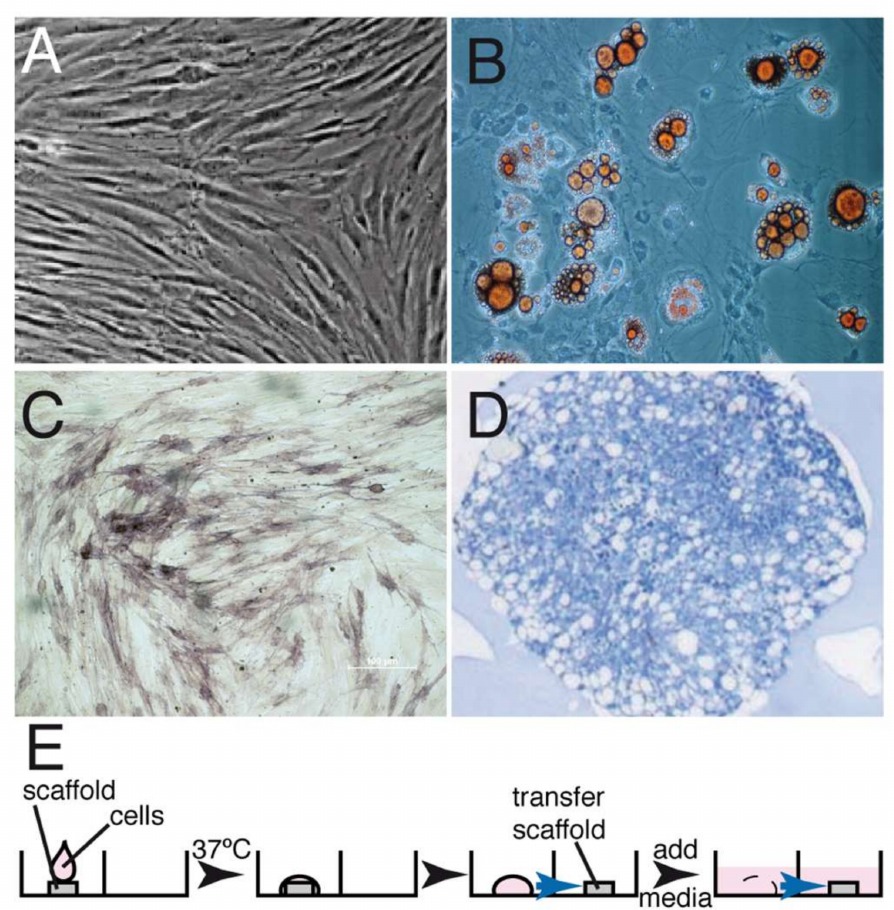
Figure 1. GMSC isolation, characterization and seeding into the matrix. GMSCs were isolated as described in Materials and Methods and expanded in tissue culture. ( A ) Phase-contrast micrography showing the exponentially growing GMSCs. These cells were then differentiated into fat cells ( B ), osteocytes ( C ) and chondrocytes ( D ). ( E ) Protocol describing the seeding of the undifferentiated GMSCs on the matrix; 2 × 10 7 cells were dropped onto a matrix, incubated at 37 ◦ C for 30 min, allowed to seed and then the matrix was transferred onto another well and media was added to cover the matrix and cells. Under the conditions used, between 50–60% of the cells were attached to the